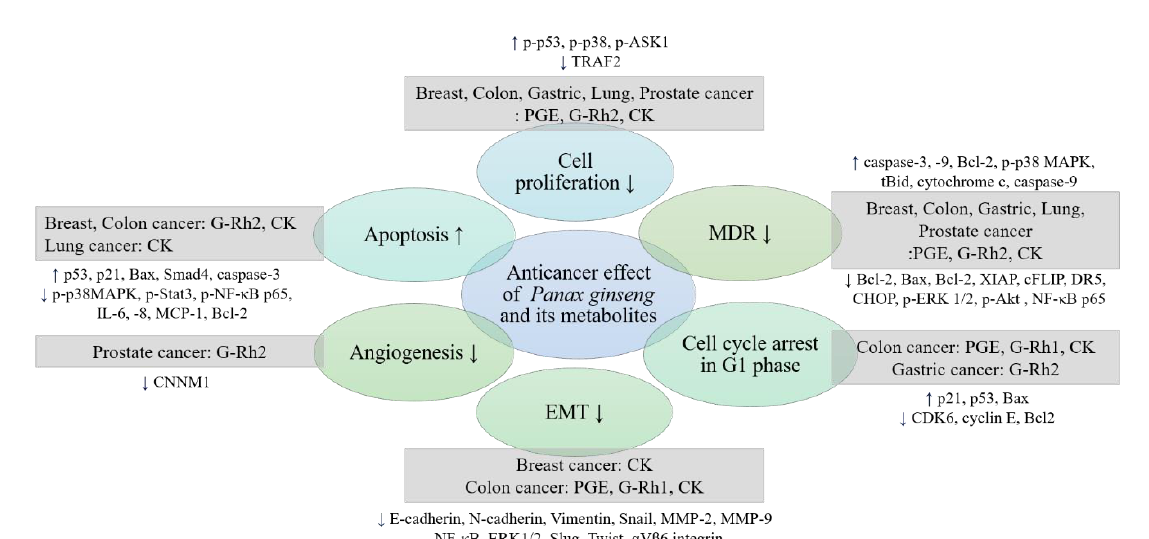
Figure 3. Schematic diagram of anti-cancer mechanisms of Panax ginseng and its metabolites. Panax ginseng and its metabolites mainly showed anticancer effects against the five major cancers through a wide range of mechanisms: The regulation of cell proliferation, apoptosis, angiogenesis, EMT (epithelial mesenchymal transition), cell cycle arrest in G1 phase, and MDR (multi-drug resistance). The figure above shows which substances follow each mechanism. Additionally, in relation to each mechanism, if there was a common factor confirmed to be regulated by each substance, it was indicated under and above the gray box. Bcl-2, B-cell lymphoma 2; CDK, cyclin-dependent kinases; CK, compound K; CNNM, cyclin and CBS domain divalent metal cation transport mediator; EMT, epithelial mesenchymal transition; ERK, extracellular- signal-regulated kinase; G-Rh, ginsenoside Rh; IL, interleukin; MAPK, mitogen-activated protein kinase; MCP, monocyte chemoattractant protein; MDR, multidrug resistance; MMP, matrix metalloproteinase; NF- κB, nuclear factor kappa B; p-ASK1, phosphorylated apoptosis signal-regulating kinase; PGE, panax ginseng extract; TRAF2, tumor necrosis factor receptor associated factor.